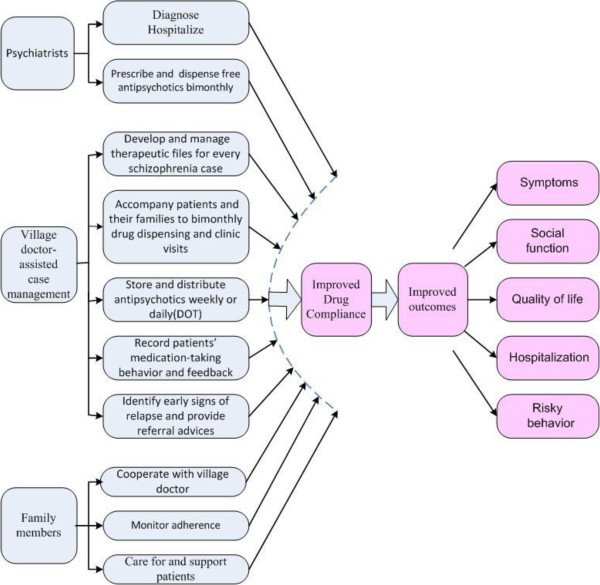
Conceptual model.